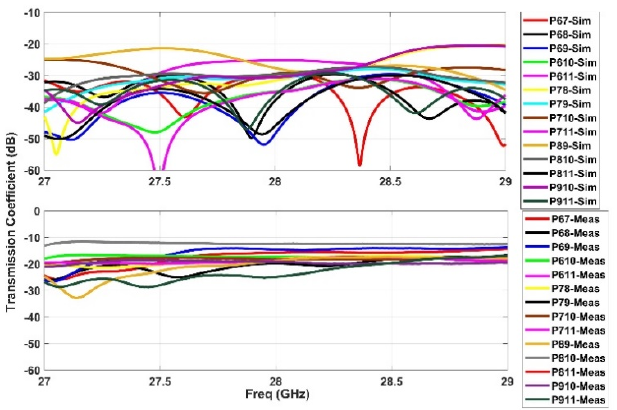
Figure 7. Simulated and measured s-parameters for the coupling among the array ports (P6–P11).